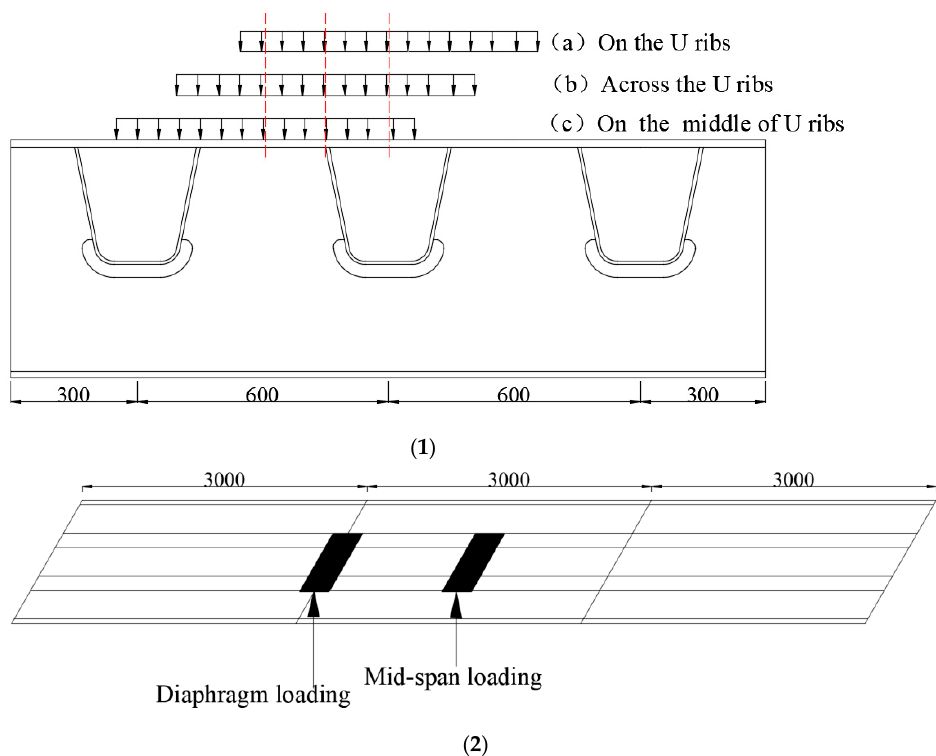
Figure 4. Wheel loading positions. ( 1 ) Wheel load in the transverse direction (unit: mm); ( 2 ) wheel load in the longitudinal direction (unit: mm).